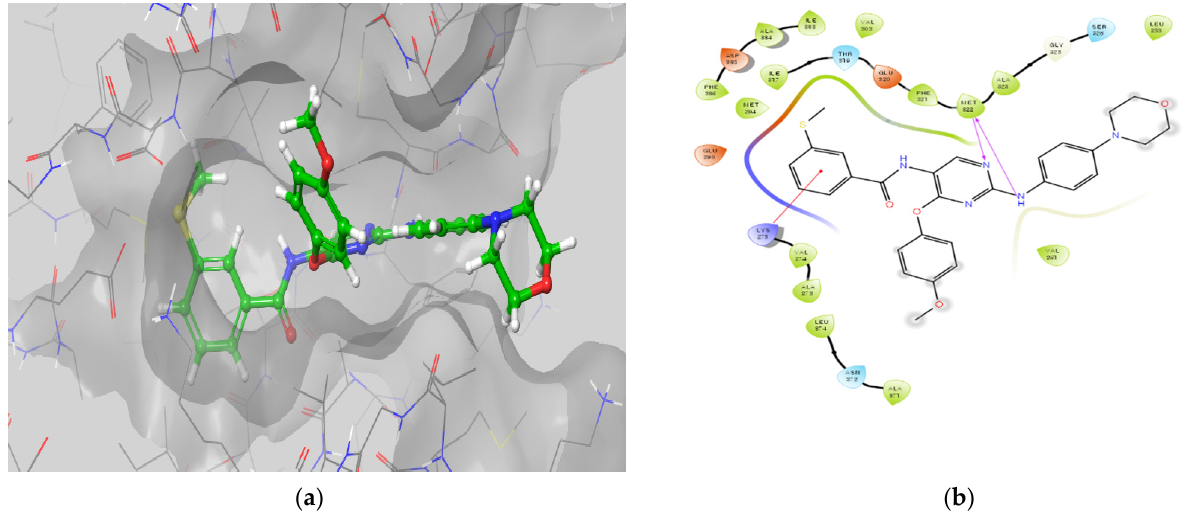
Figure 7. Docked complex of compound 5g with LYN. ( a ) 3D docking model of compound 5g into LYN binding pocket. ( b ) 2D interaction diagram of compound 5g with LYN.